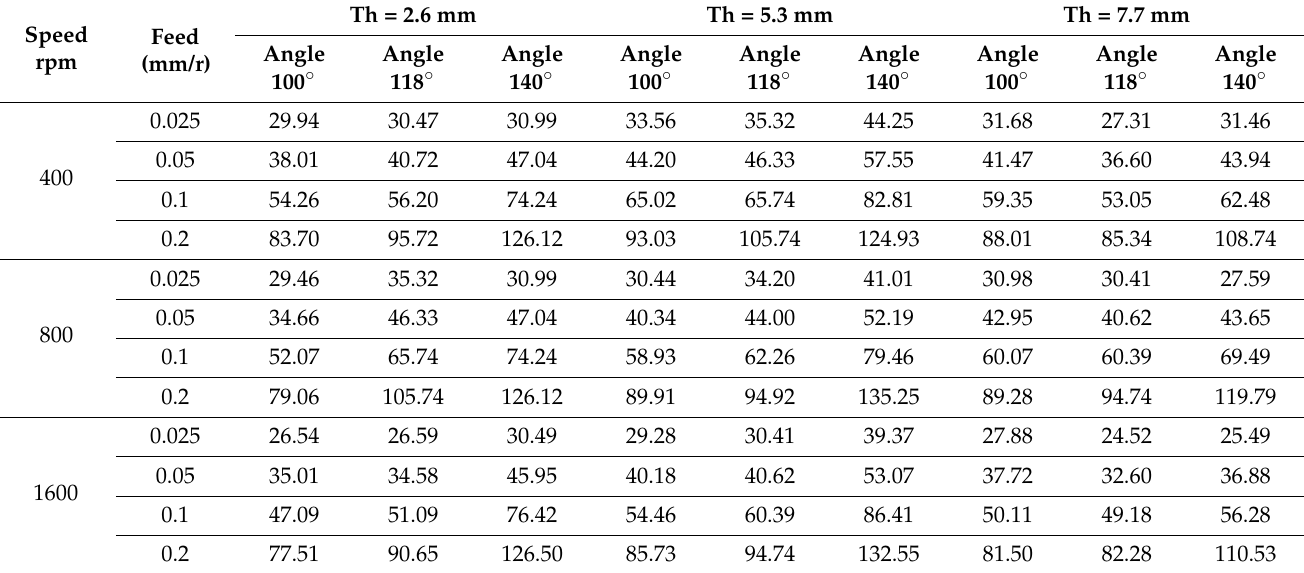
Table 7. The variation of critical thrust force with speed, feed, thickness, and point